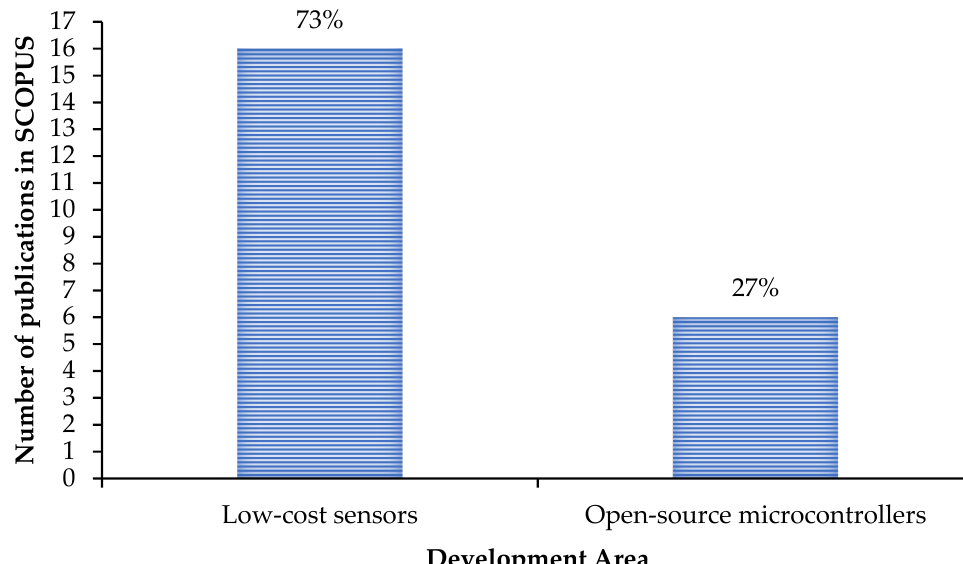
Figure 8. Two areas of development in the SCOPUS database for the application of low-cost corrosion monitoring solutions using the EIS technique: Area 1 focusing on the development of the sensing elements, and Area 2 focusing on the use of open-source microcontrollers as the low-cost data acquisition system.